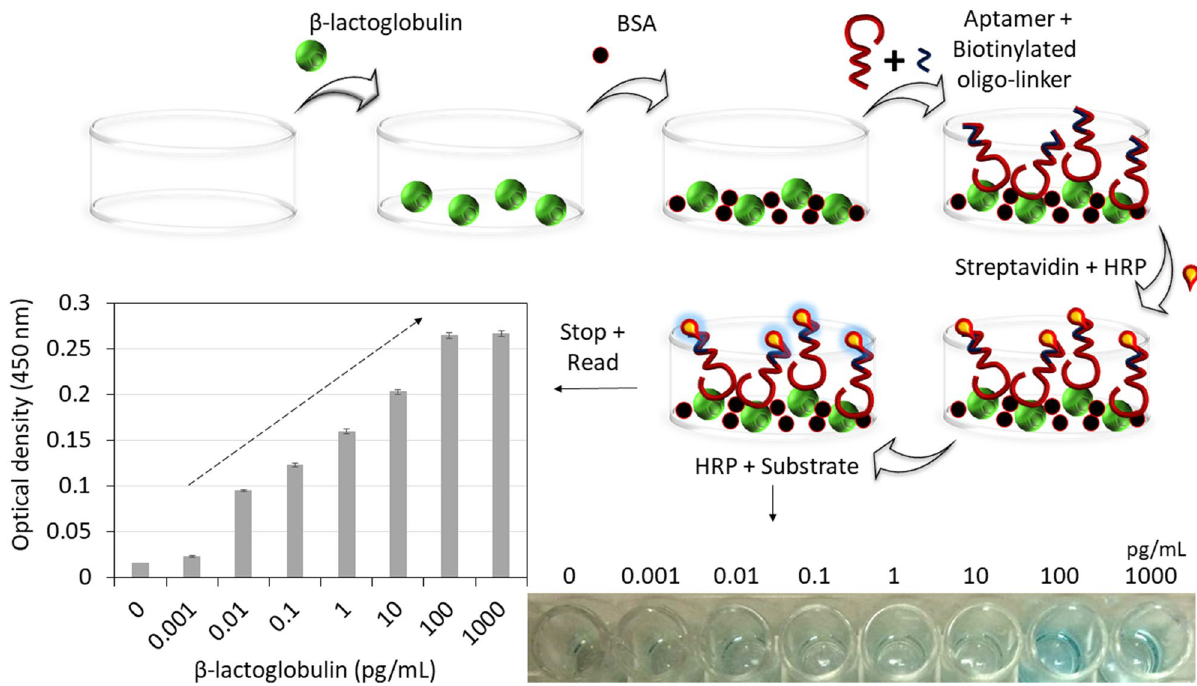
Figure 7. Validation by Enzyme-linked aptasorbent assay. Schematic image with the steps involved is shown. β-lactoglobulin concentrations from 0.001 until 1000 pg/ml were interacted with the constant aptamer concentration (50 nM). The results are displayed by bar-chart and arrow indicates the linear range. The photographed wells are shown as a